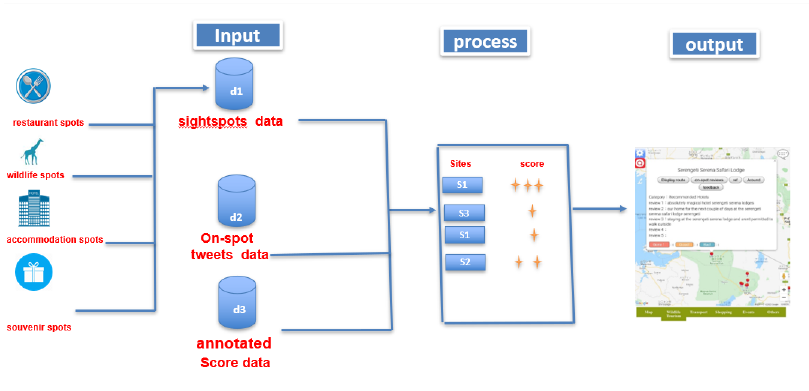
Figure 10. System overview. Further use the computed score to represent the sightspot rating information (see Figure 13).